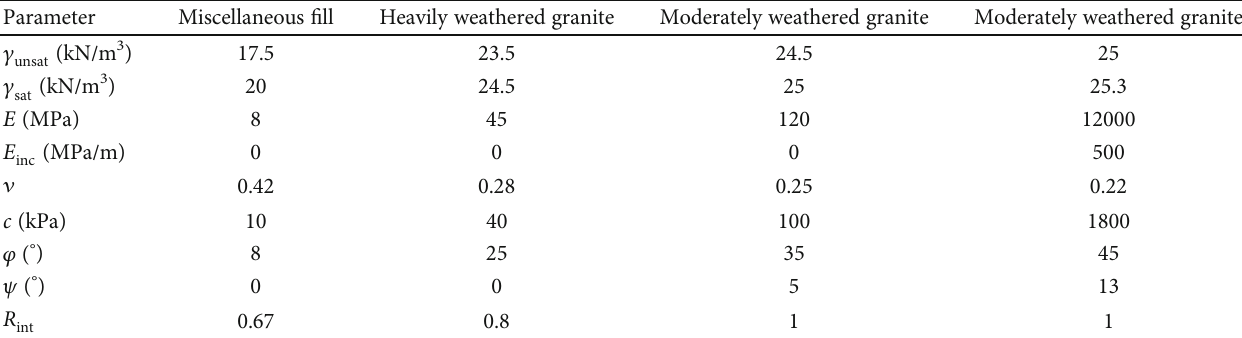
Table 2: Soil parameters adopted in fi nite element analysis.